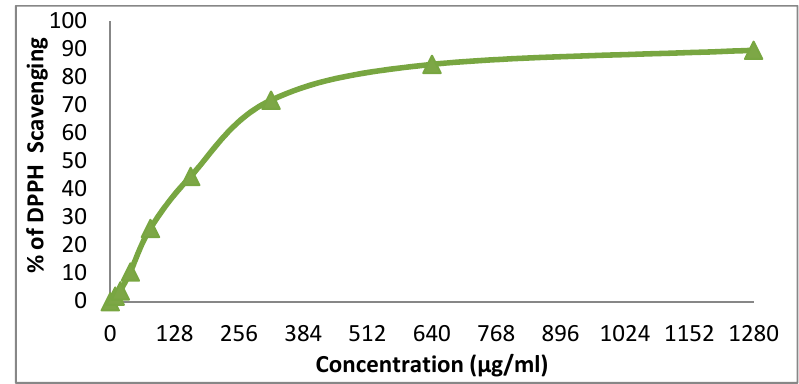
Figure 12. Evaluation of the antioxidant effect of disperse dye 14y.